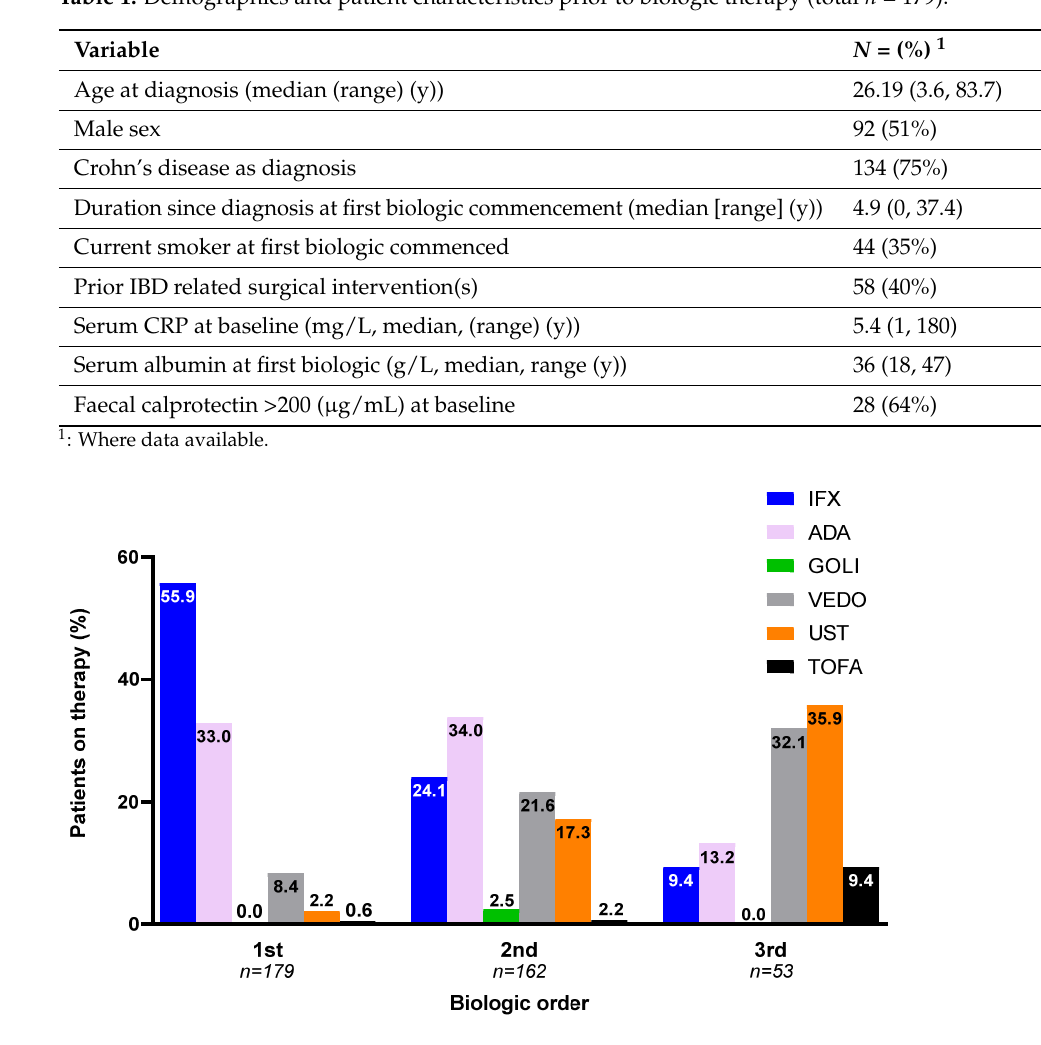
Table 1. Demographics and patient characteristics prior to biologic therapy (total n = 179).